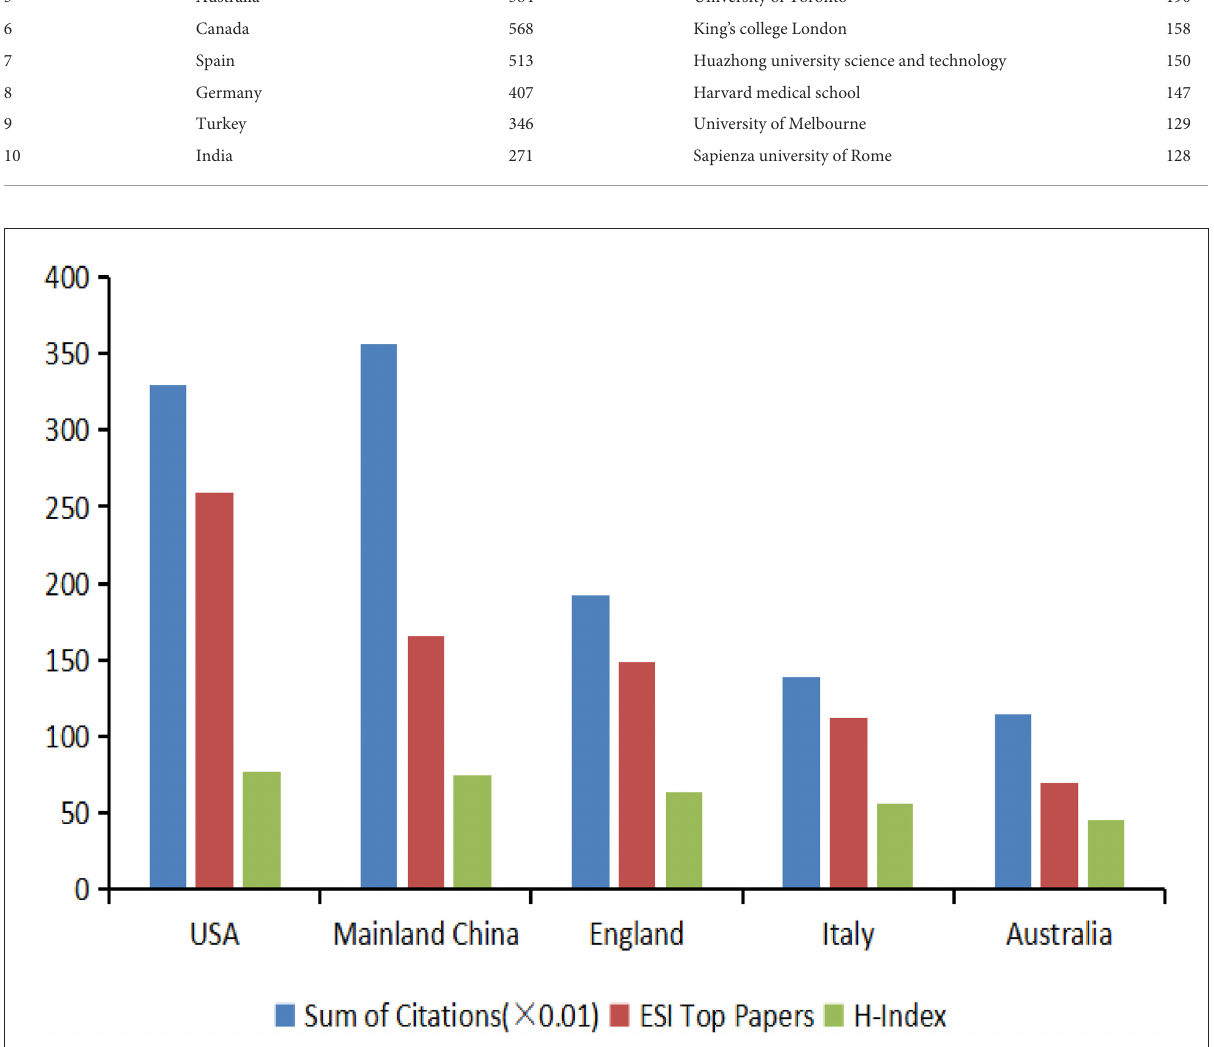
FIGURE3 The distribution of citation (